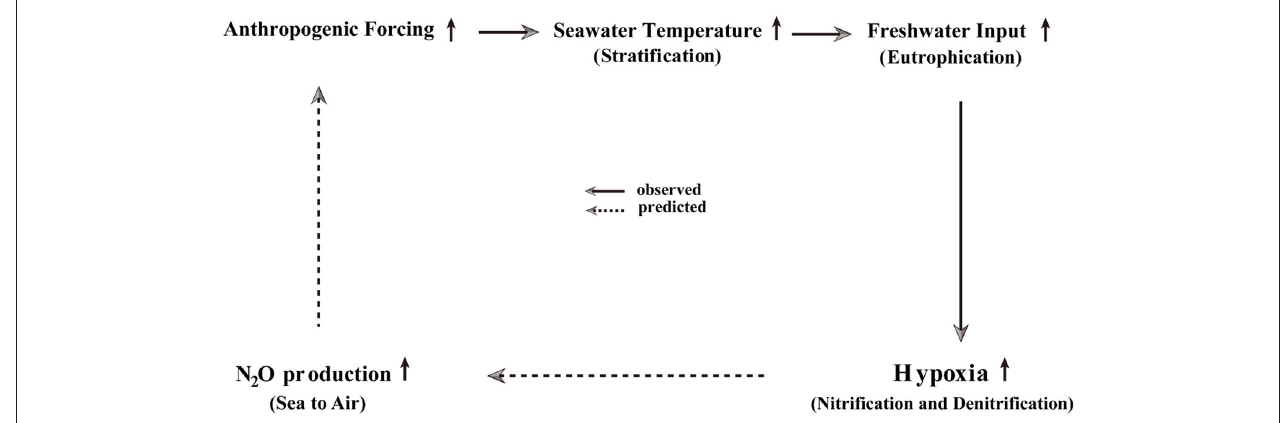
FIGURE 3 | A conceptual feedback scheme for future N 2 O emission in the nGOM, based on physical changes currently occurring in the